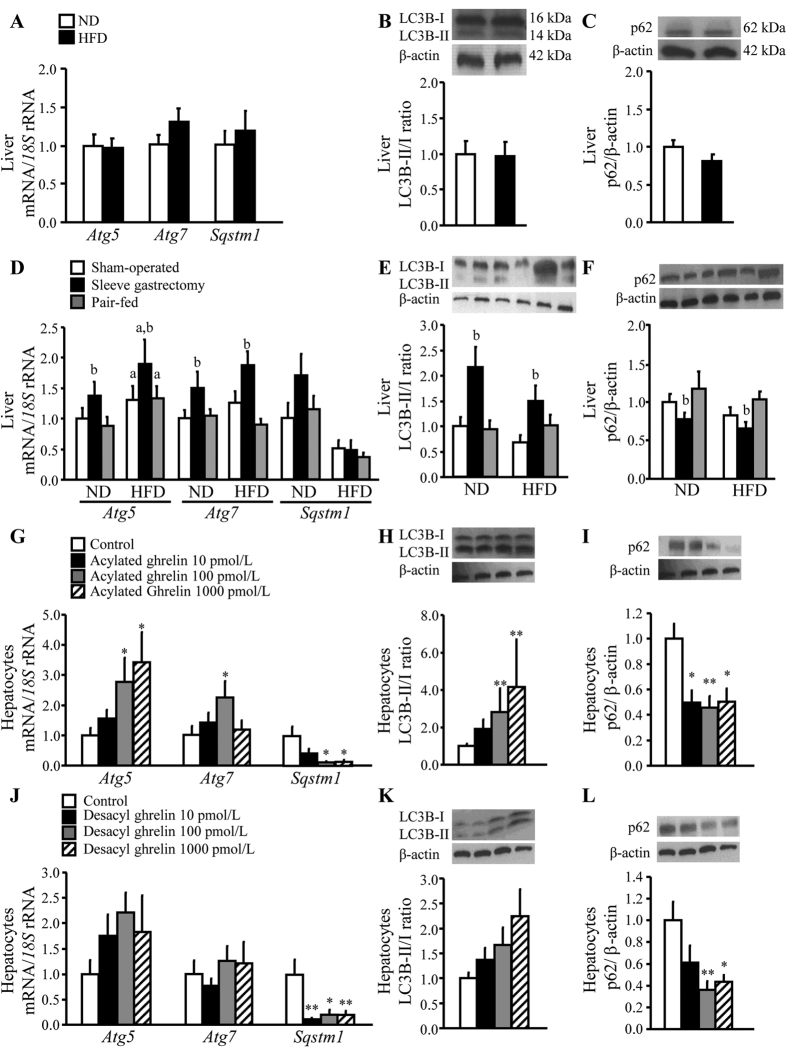
Impact of acylated and desacyl ghrelin on the activation of autophagy after sleeve gastrectomy.Effect of obesity and sleeve gastrectomy on the expression of Atg5, Atg7 and Sqstm1 genes (A,D), autophagosome formation as evidenced by the LC3B-II/I ratio (B,E) as well as autophagy inhibition determined by p62 accumulation (C,F) in liver samples of the experimental groups. Representative cropped blots are shown at the top of the figures. Effect of acylated (G,H,I) and desacyl (J,K,L) ghrelin on key autophagy factors in rat hepatocyte cultures. The gene expression in lean rats, in the sham-operated groups fed a normal diet and in unstimulated hepatocytes was assumed to be 1. aP < 0.05 effect of diet; bP < 0.05 effect of surgery. *P < 0.05; **P < 0.01 vs unstimulated hepatocytes.